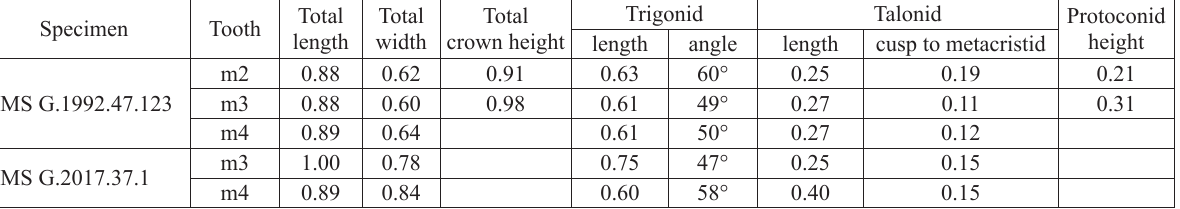
Table 1. Dental measurements (in mm) for Palaeoxonodon ooliticus Freeman, 1976b, NMS G.1992.47.123 and NMS G.2017.37.1. Measurements follow Sigogneau-Russell (2003) and Close et al. (2016). Trigonid Talonid Protoconid Total Total Total Specimen Tooth length width crown height heightlength angle length cusp to metacristid NMS G.1992.47.123